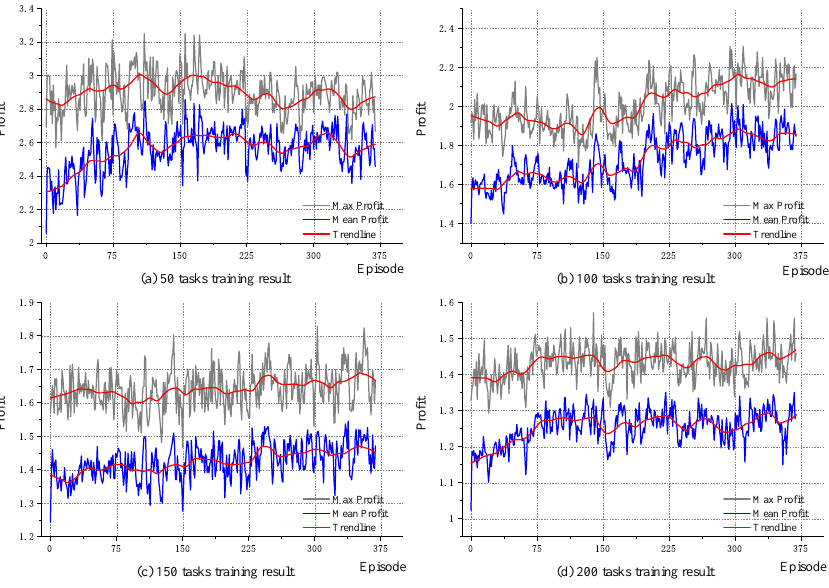
Figure 10. Profit curves of training